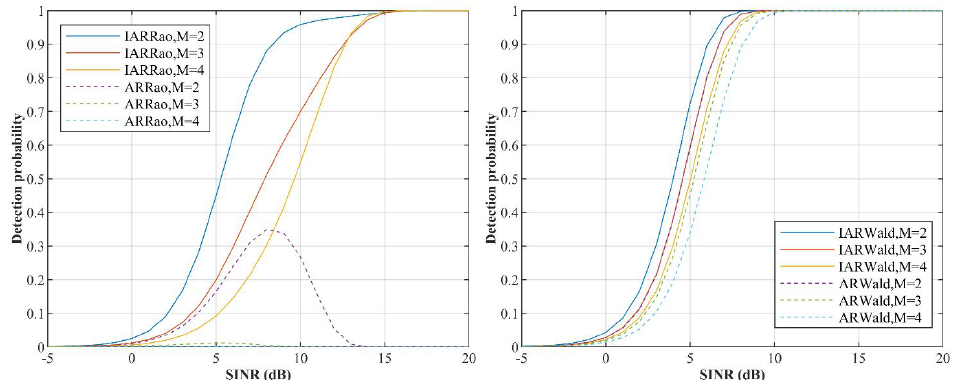
Figure 5. P d versus SINR for P fa = 10 − 4 , N = 16, L = 8 and K = 3. ( left ) Performances of AR-Rao and IAR-Rao; ( right ) performances of AR-Wald and IAR-Wald.